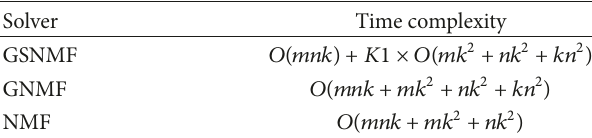
Algorithm 2. To optimize subproblem (10), the operation